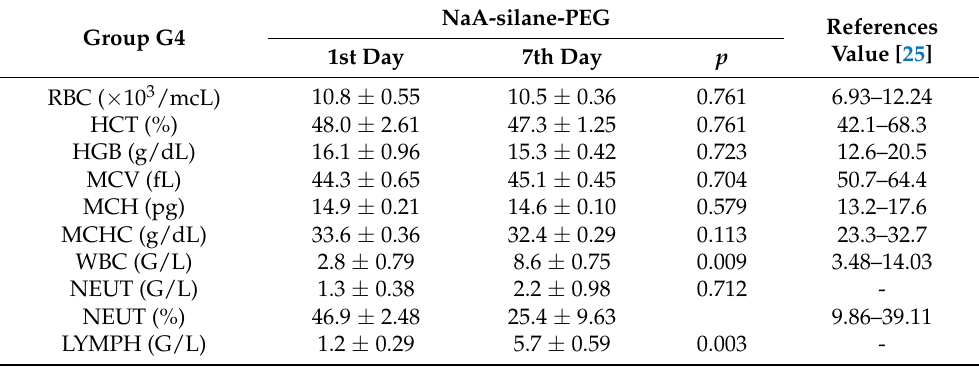
Table A4. Hematological parameters of blood of BALB/c mice at 1 and 7 days post injection with